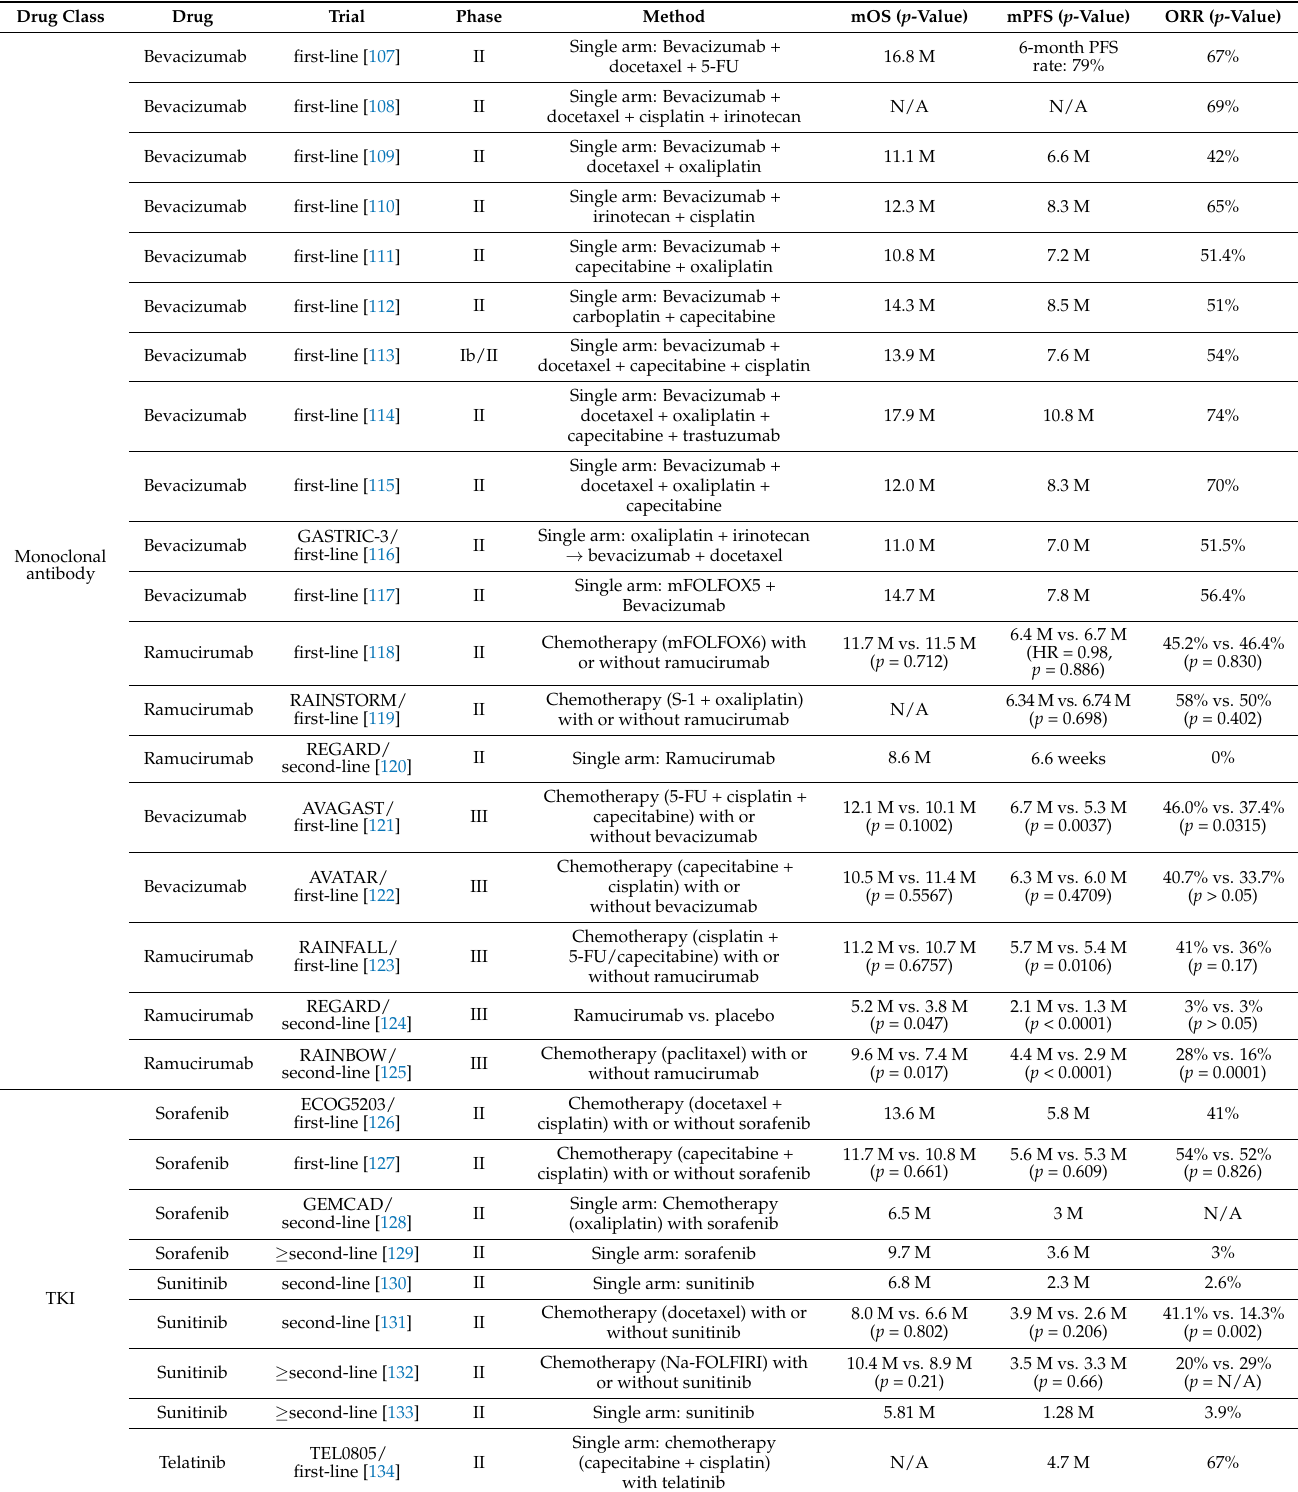
Table 3. Phase II and III trials of therapies targeting angiogenesis. mOS, median overall survival; mPFS, median progression-free survival; HR, hazard ratio; M, months; ORR, objective response rate; 5-FU, 5-fluorouracil; FOLFOX, folinic acid, fluorouracil, oxaliplatin, oxaliplatin; FOLFIRI, folinic acid, fluorouracil, irinotecan; N/A, not available; TKI, tyrosine kinase